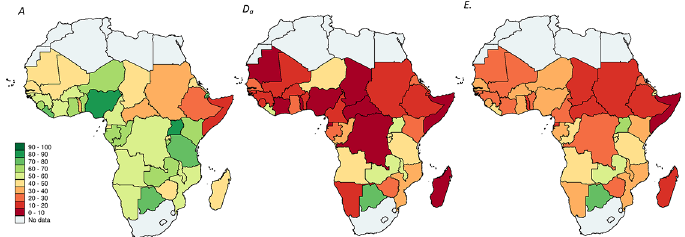
Fig 5. Access, First-Line Antimalarial Treatment, and Effective Coverage of Malaria Case Management by Country. A. Access to any provider; D a Compliance with the first-line antimalarial treatment; C. Effective coverage. Maps were generated by authors using spmap command[73] in Stata 13 SE; Country coordinates were sourced from Global Administrative Areas